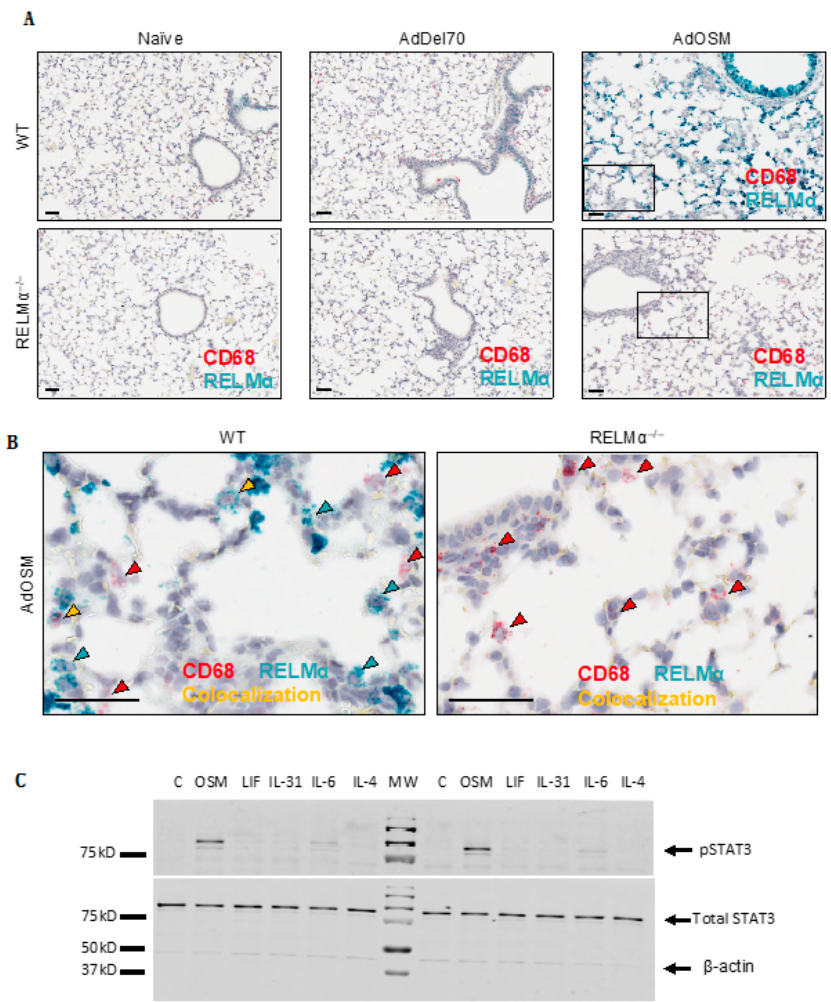
Figure 2. RELM α mRNA is highly induced in columnar airway epithelial cells. ( A ) Representative images ( n = 5 mice / group) are shown of CISH staining for RELM α (green-blue) and CD68 (red, a macrophage marker) in formalin-fixed para ffi n-embedded lung tissue sections from naïve, AdDel70- or AdOSM-treated at day 7 as indicated in wild-type (upper panels) or RELM α – / – mice (lower panels). Scale bars, 50 µ m. ( B ) High magnification images of indicated regions (boxed) from AdOSM-treated mouse lungs from right panels of ( A ) RELM α (green-blue) and CD68 (red) mRNA signals show as punctate dots unless at very high levels in which signals converge. Scale bars, 50 µ m. Co-localization of both signals is indicated as yellow arrowheads in wild-type mice. ( C ) C57Bl / 6-derived murine airway epithelial cells were stimulated in vitro for 1 h with 20ng / ml of OSM, leukemia inhibitory factor (LIF), IL-31, IL-6 or IL-4 and whole cell extracts probed for phospho-STAT3 (pSTAT3), total STAT3 and β -Actin by Western Blotting. Two separate cell culture experiments are